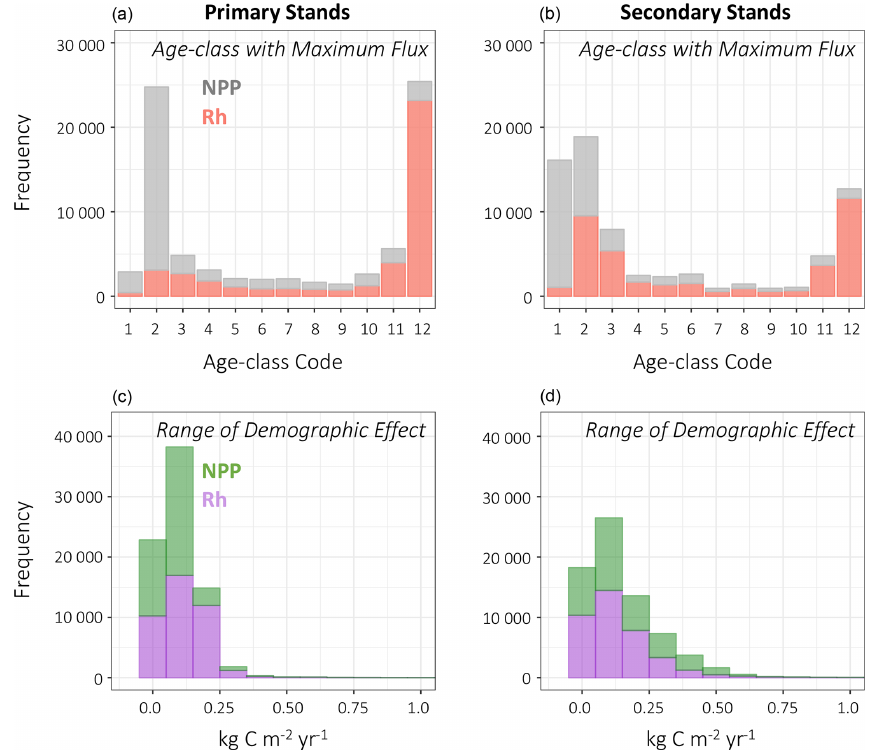
Figure 12. Stacked frequency plots for NPP and Rh on primary and secondary stands. (a, b) Global frequency of age classes with the largest flux (NPP, Rh) relative to other age classes in the grid cell. Age-class codes, lowest (youngest) to greatest (oldest), correspond to the 10-yr-equalbin age-class setup (Table 1). (c, d) Global frequency of the range of the demographic effect on fluxes; bin width is 0.10kgCm − 2 yr − 1 . An example interpretation, on primary stands: (a) NPP is greatest in the second age class, and (c) the demographic effect on NPP is < 0 . 25kgCm − 2 yr − 1